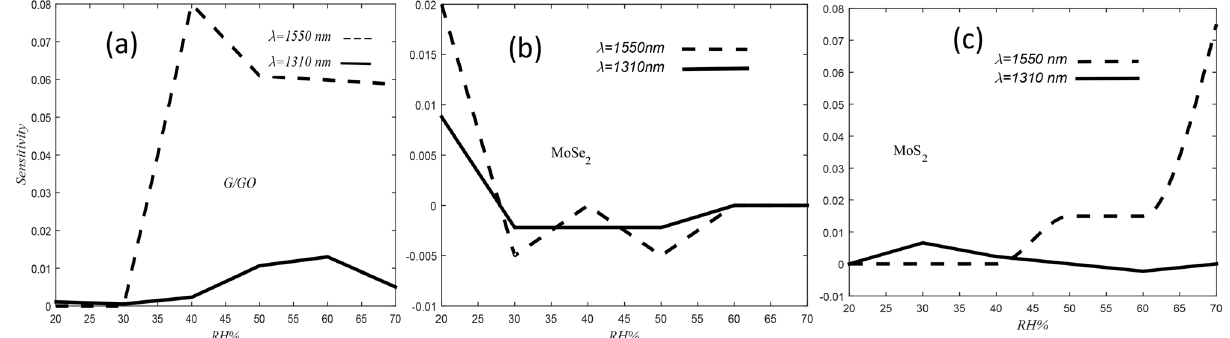
Figure 8. Sensitivity of humidity sensors coated with (a) G/GO, (b) MoSe 2 and (c) MoS 2 in both 1310 nm (line curves) and 1550 nm (dash-line curves)